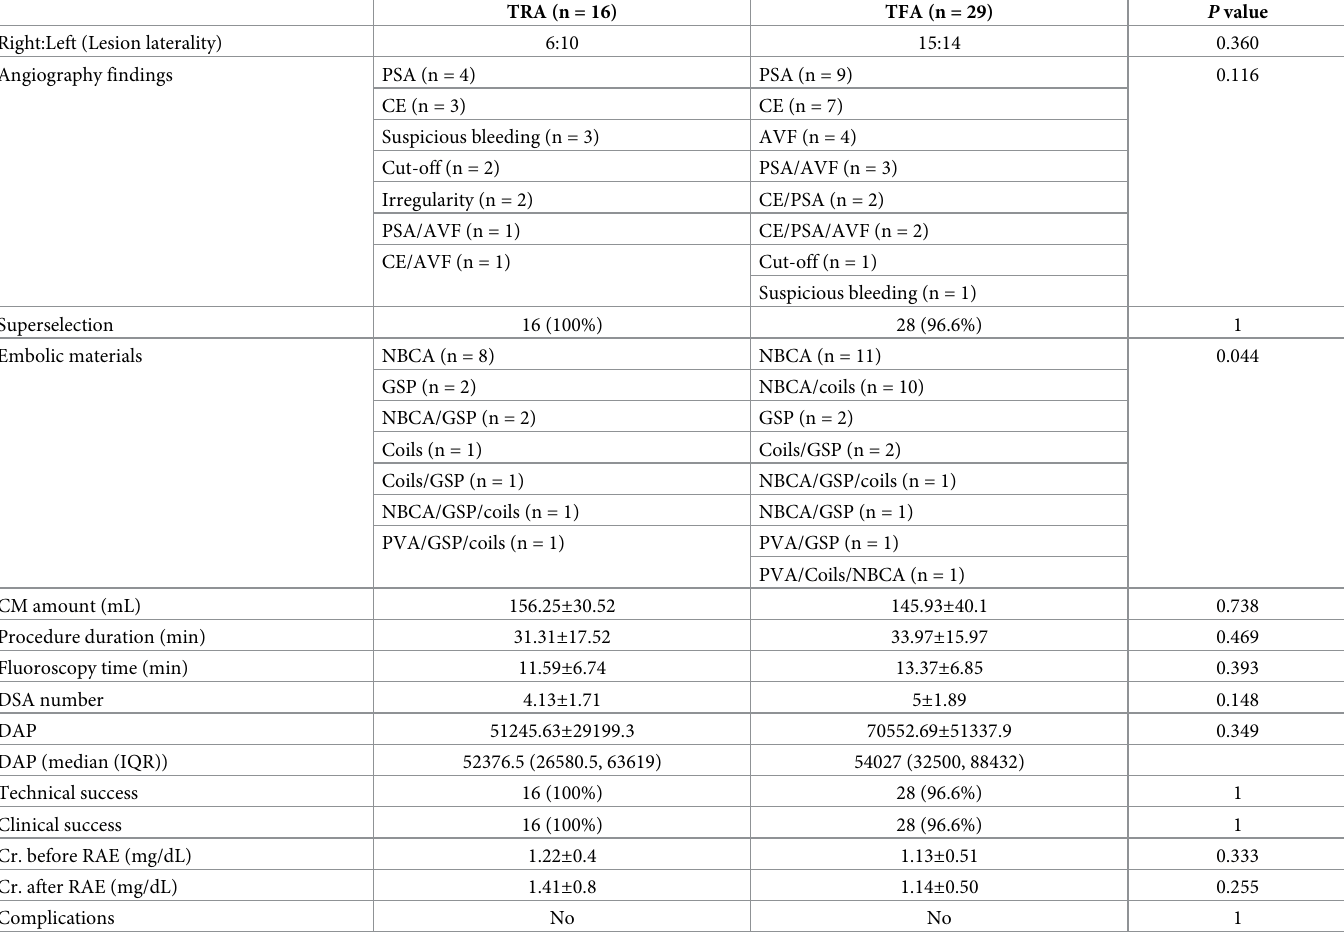
Table 2. Angiography findings, embolization details, radiation exposure, and clinical